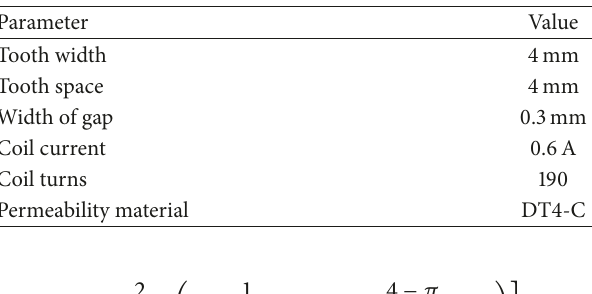
Table 1: Simulation parameters. Table 2: Parameters of analytical electromagnetic force.